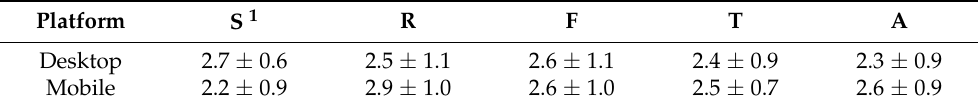
Table A1. Use of GIS platforms.